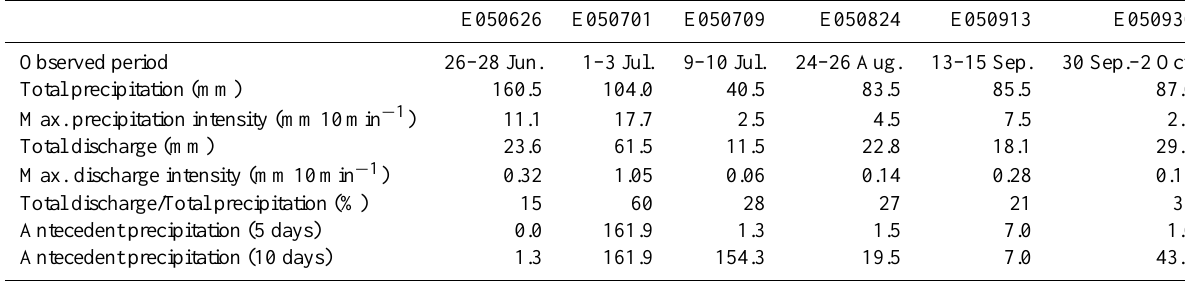
Table 3. Hydrological characteristics of the six storm events from June to October